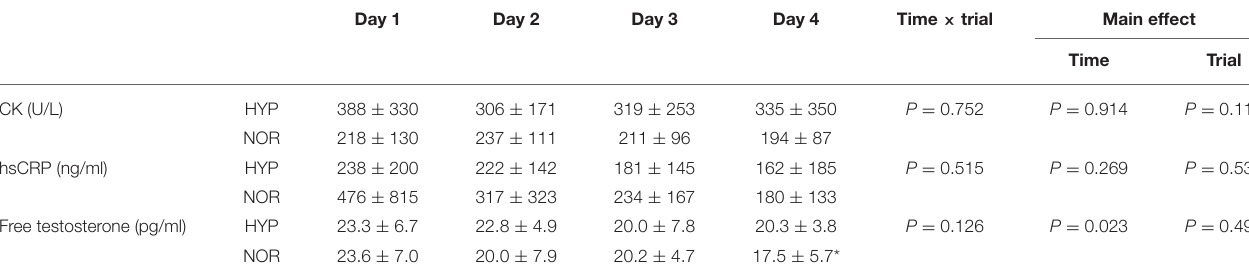
TABLE 2 | Changes in blood variables.